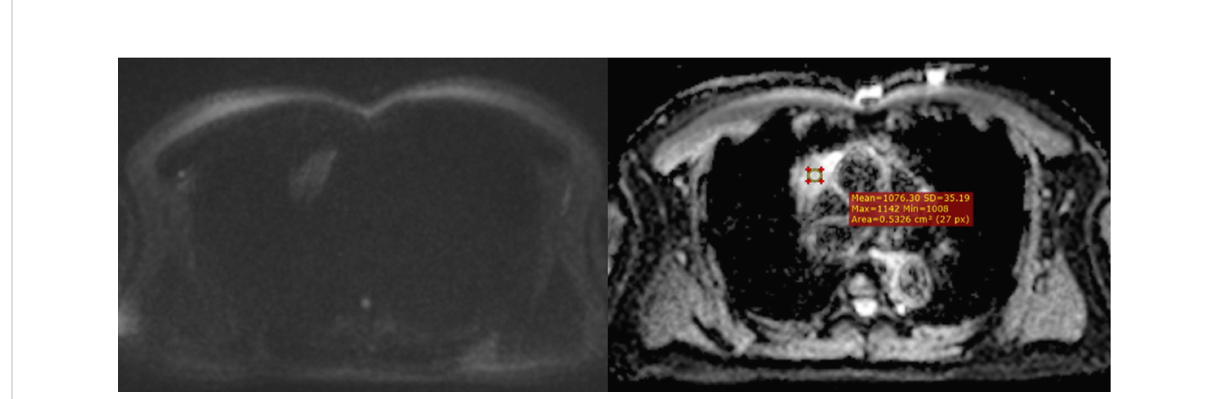
FIGURE 7 Type AB thymoma on DWI/ADC map. A case of con fi rmed type AB thymoma, correctly classi fi ed as a low-risk thymoma on pre-surgical MRI. The mean of 3 ADC values obtained by using the hot-spot-ROI-based approach was 1.05 x 10-3